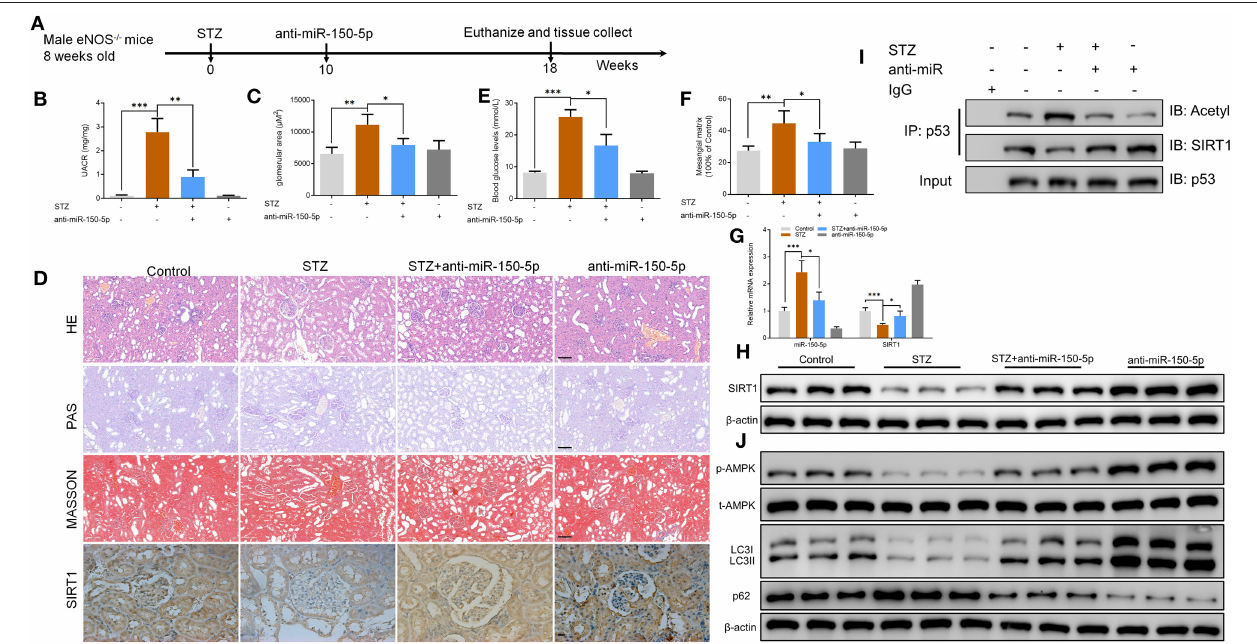
FIGURE 6 | Silencing of miR-150-5p ameliorated kidney injury in type 1 diabetic mice. (A) eNOS − / − mice were injected (i.p.) with STZ 50 mg/kg after 6h of food deprivation each day for 5 consecutive days to induce diabetes. After 10 weeks, mice were given weekly intravenous injections of anti-miR-150-5p lentivirus for 8 weeks and then euthanized. (B) The level of urinary albumin-to-creatinine ratio (UACR) in mice. (C) The level of blood glucose in mice. (D) Representative images of hematoxylin–eosin (HE) ( × 200), periodic acid–Schiff (PAS) ( × 200), Masson-stained ( × 200), and immunohistochemistry of sirtuin 1 (SIRT1) ( × 400) in kidneys. Scale bar = 100 µ m. (E,F) Quantification of the glomerular area and mesangial area fraction in mice kidney tissues. (G) The levels of miR-150-5p and SIRT1 in podocytes were determined using qRT-PCR in mice kidney tissues. (H) The protein levels of SIRT1 in podocytes were determined using Western blot in mice kidney tissues. (I) Acetylation and SIRT1 was determined in p53 IP, and total p53 was determined on total extracts as input in mice kidney tissues. (J) The levels of p-AMPK, LC-3, and p62 in podocytes were determined by Western blot in mice kidney tissues. Data are expressed as mean ± SEM ( n = 6; * p < 0.05, ** p < 0.01, *** p <